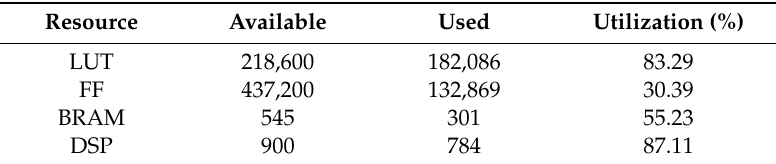
Table 2. The overall resource utilization of the design.